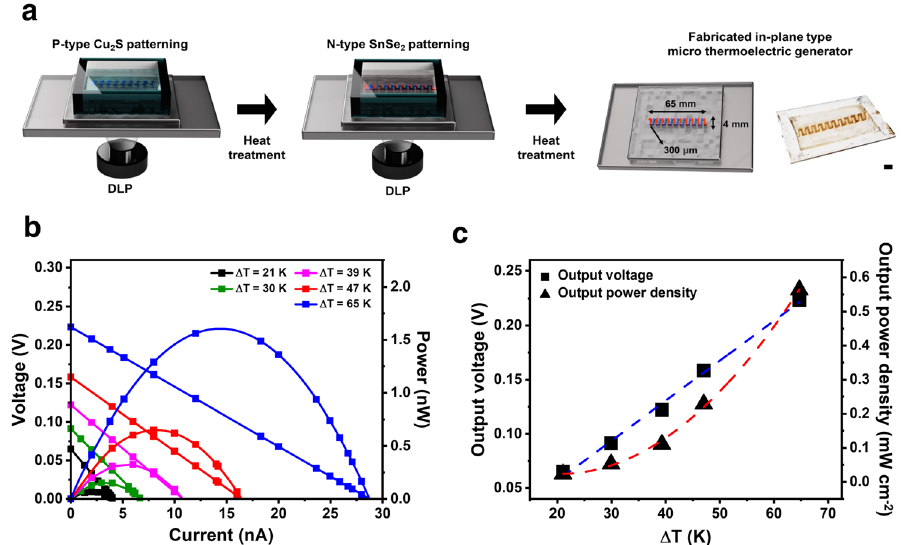
Fig.5|Fabricationandevaluationofthemicro-scalethermoelectricgenerator. a Scheme of the fabrication of the micro-scale thermoelectric generator by DLP- basedopticalprinting.(Scalebar:5mm)Tofabricatethethermoelectricgenerator, thep-typeCu 2 Slegswereinitiallypatternedandheat-treatedat723K,andthenthe n-type SnSe 2 legs were patterned and annealed at 573K. b Output voltages and